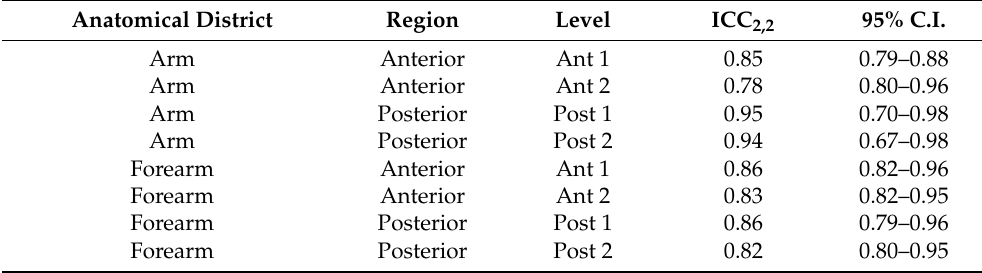
Table 11. Inter-rater reliability of the ultrasound measurements within different regions/levels of the superficial fascia of the arm and forearm between the two